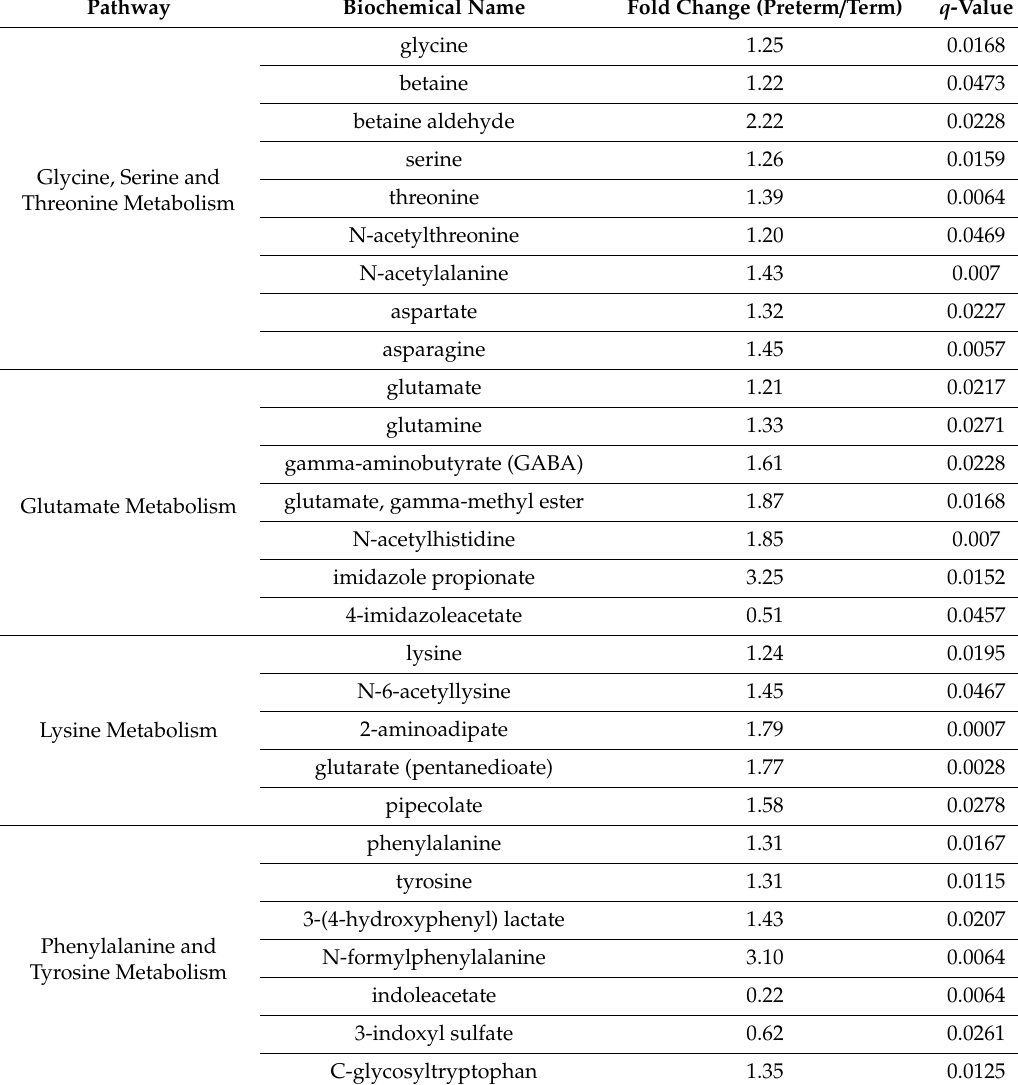
Table 2. Fold change in amino acids that are significantly altered in SPTB placenta. Pathway Biochemical